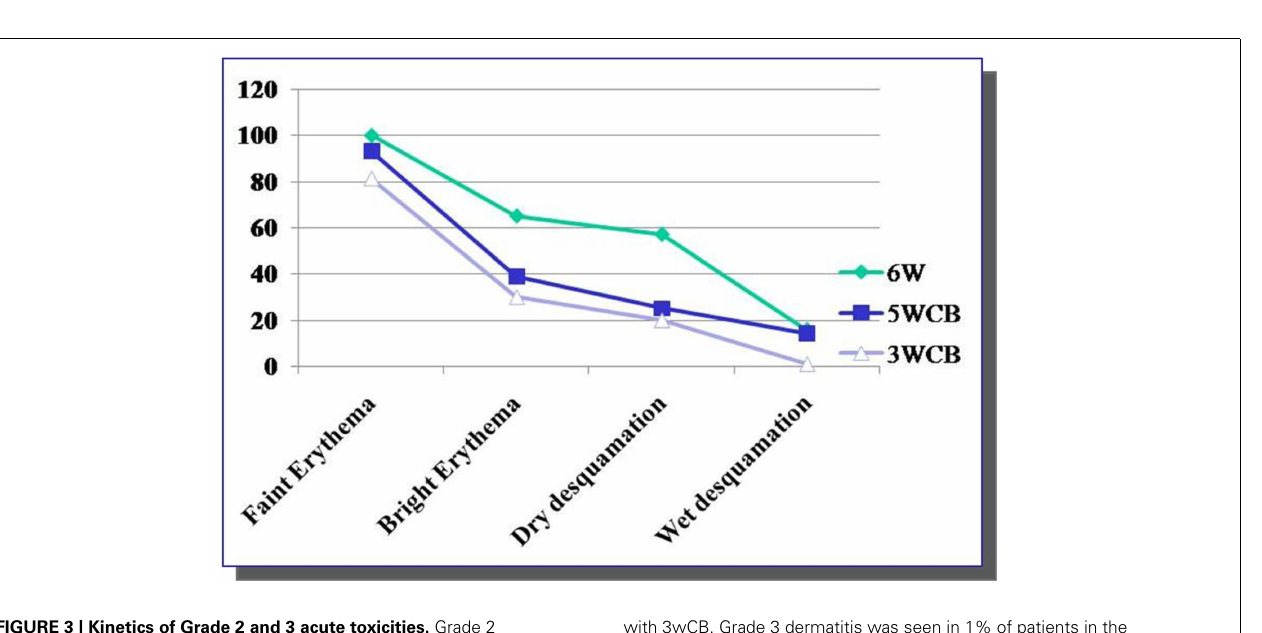
with 3wCB. Grade 3 dermatitis was seen in 1% of patients in the 3wCB and 4% of patients on the 6wSB schedule at 3 and 6weeks,